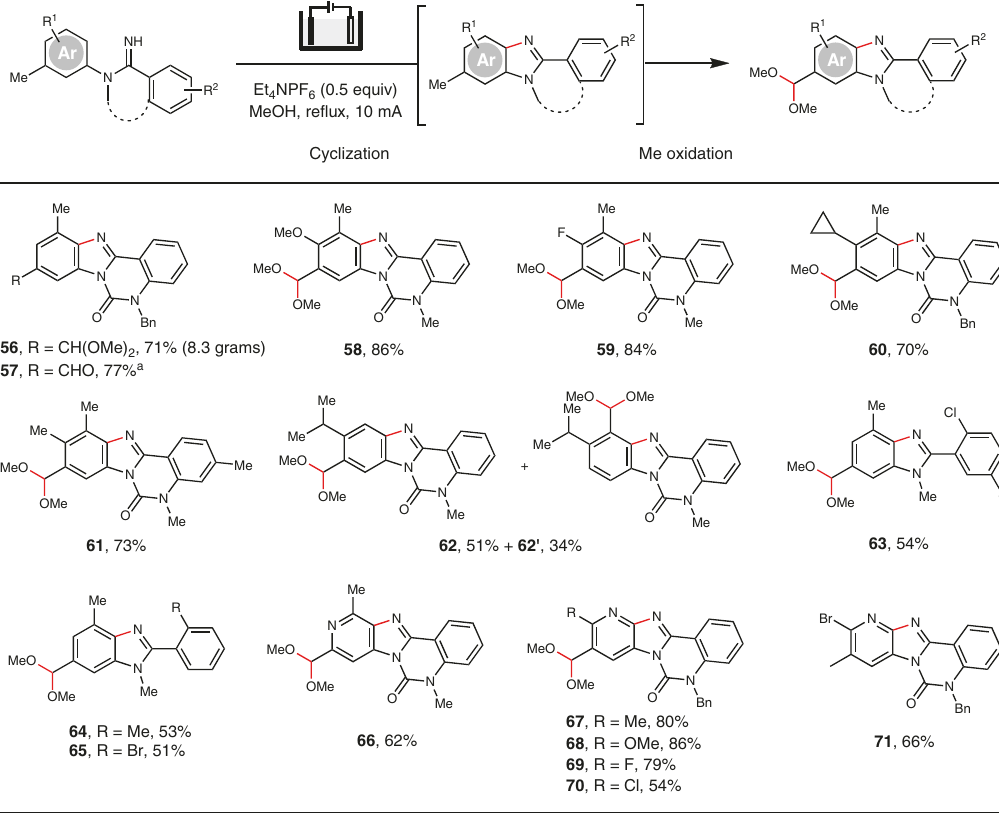
Fig. 4 Electrochemical cyclization/benzylic oxidation of amidines. General reaction conditions: amidine (0.2 mmol), MeOH (0.022 M), re fl ux, 3.5 – 12.5 h. All yields are isolated yields. Regioisomers were not observed unless otherwise mentioned. a Electrolysis was followed by one-pot hydrolysis with HCl (2